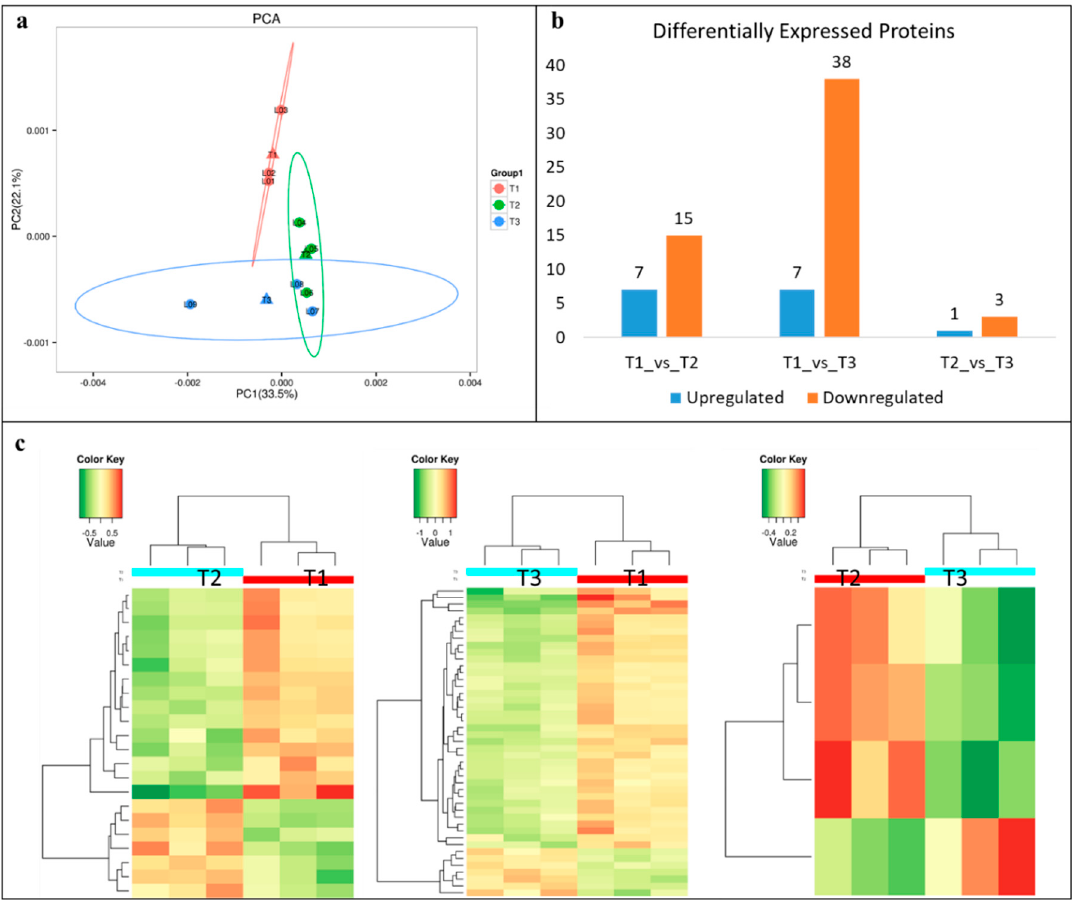
Figure 6. ( a ) Principal component analysis, ( b ) summary of differentially expressed proteins, and ( c ) heatmaps of the expression of the differentially expressed proteins between different treatments. A protein (c309809; E.C.1.7.7.1) NiR was downregulated in T3 as compared to T1 and